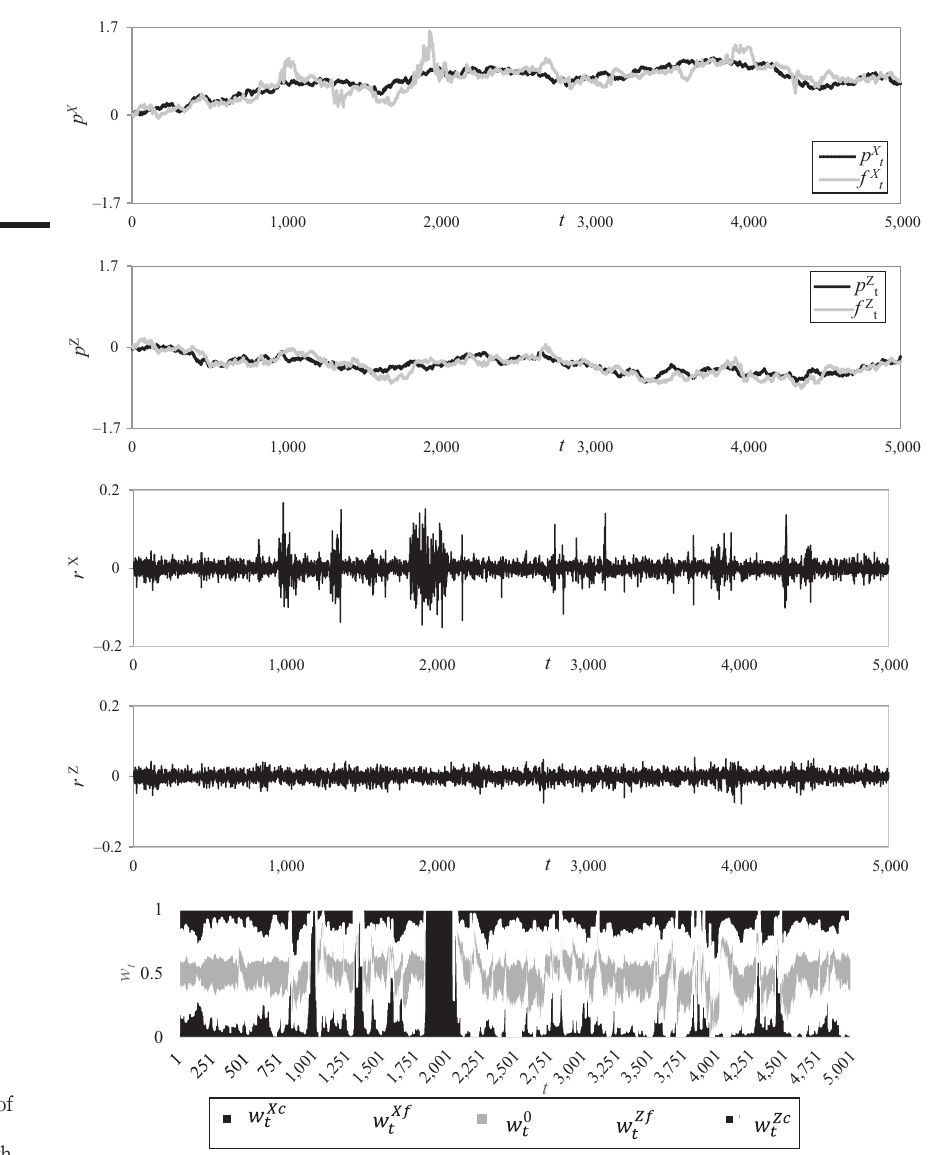
Figure 9. The impact of imposing a transaction tax of 0.25 per cent in market X on both markets ’ log prices, asset returns and weights of trading